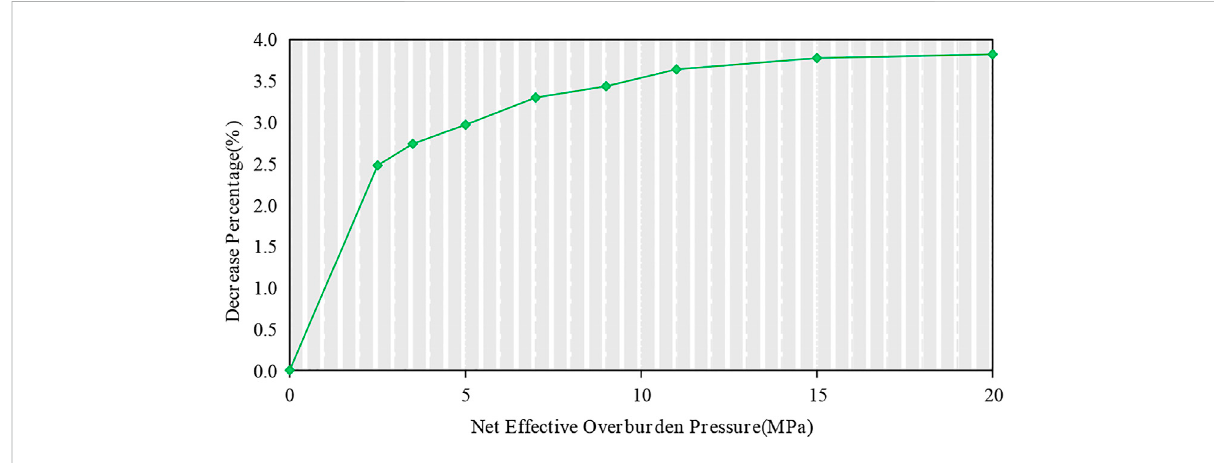
FIGURE 9 Decrease percentage of overburden porosity with